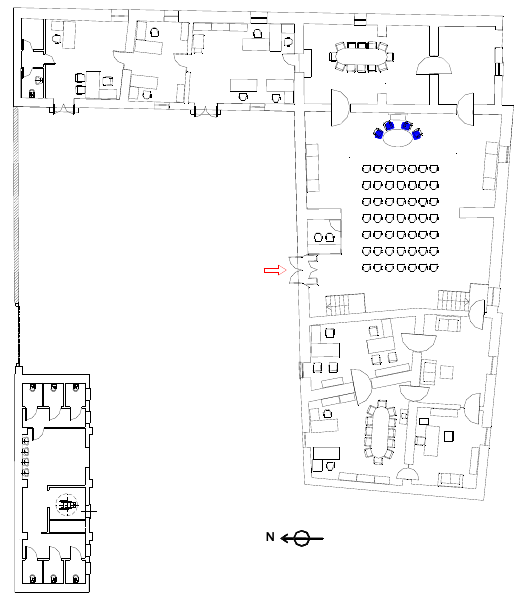
Figure 3. Ground and upper ground floor planimetry.